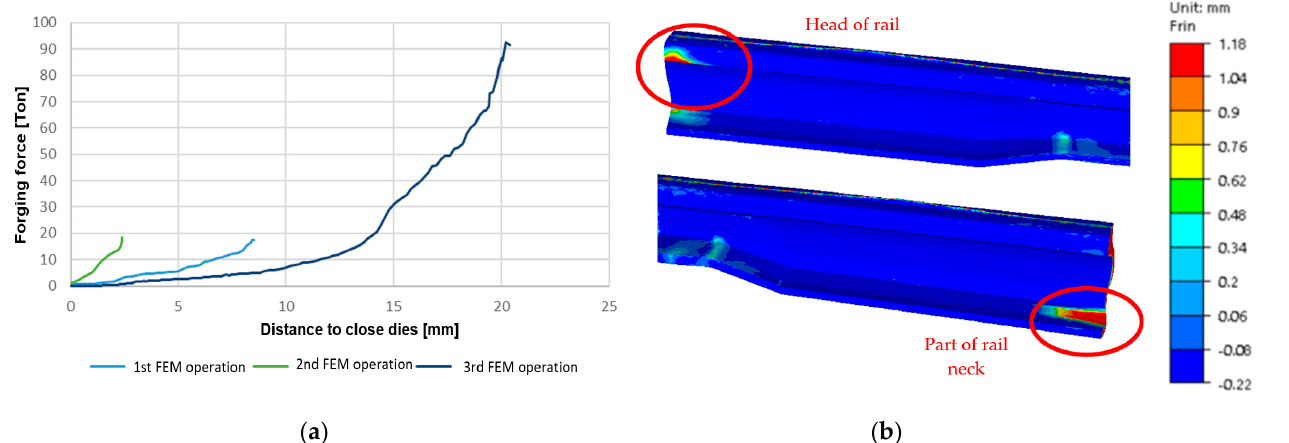
Figure 4. View of: ( a ) the forging force courses for the particular operations, ( b ) the forging defects in the form of underfills on the foot and the head of the reforged rail.